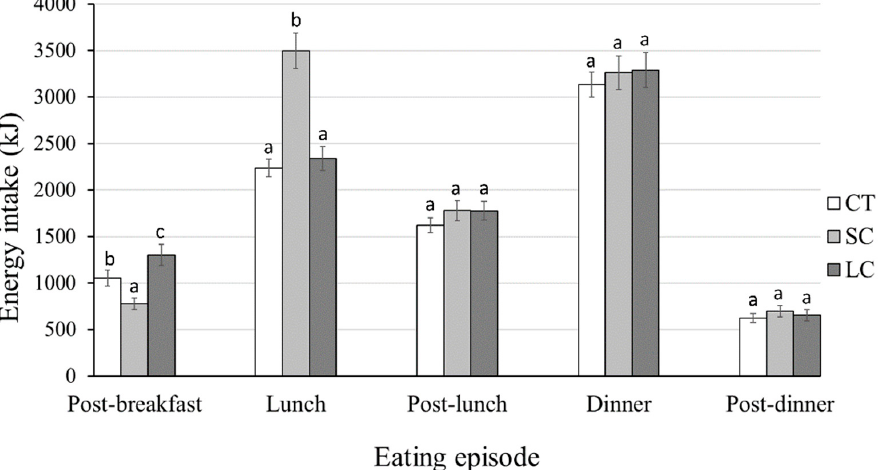
Figure 3. Bar charts illustrating the downstream energy intake across jar size conditions (CT, SC, LC) at post-breakfast, lunch, post-lunch, dinner, and post-dinner eating episodes for N = 40 participants. Data are reported as mean ± standard error. Assigned letters in the figure indicate significant differences across the conditions at each eating episode ( p < 0.05).